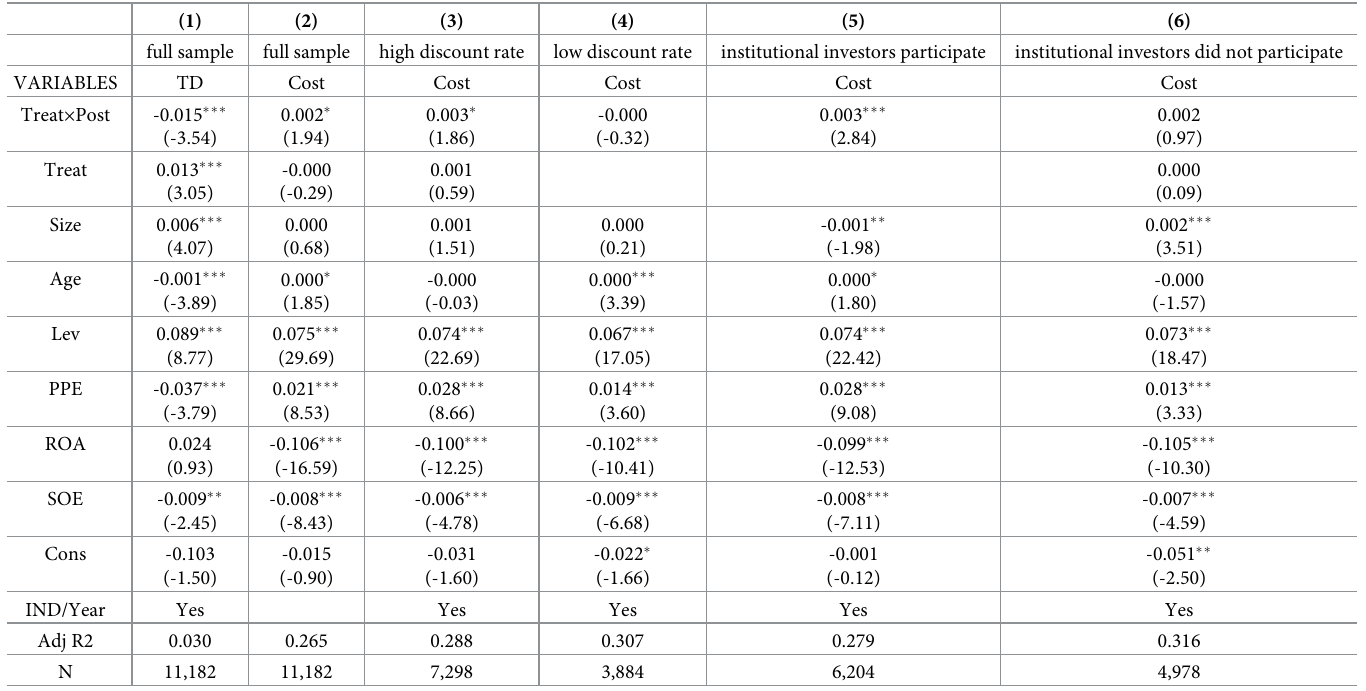
Table 7. Results of robustness